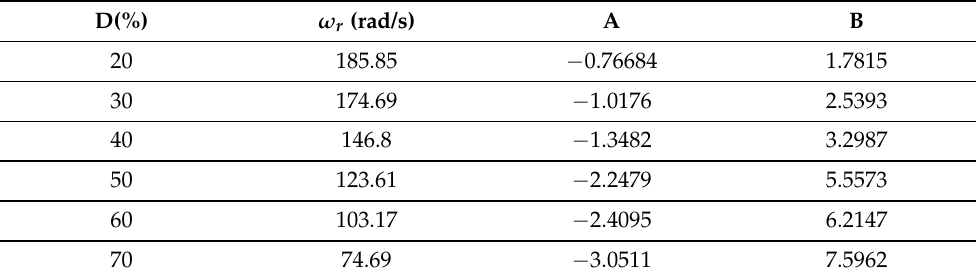
Table 3. Values of the system parameters for the correspondent duty